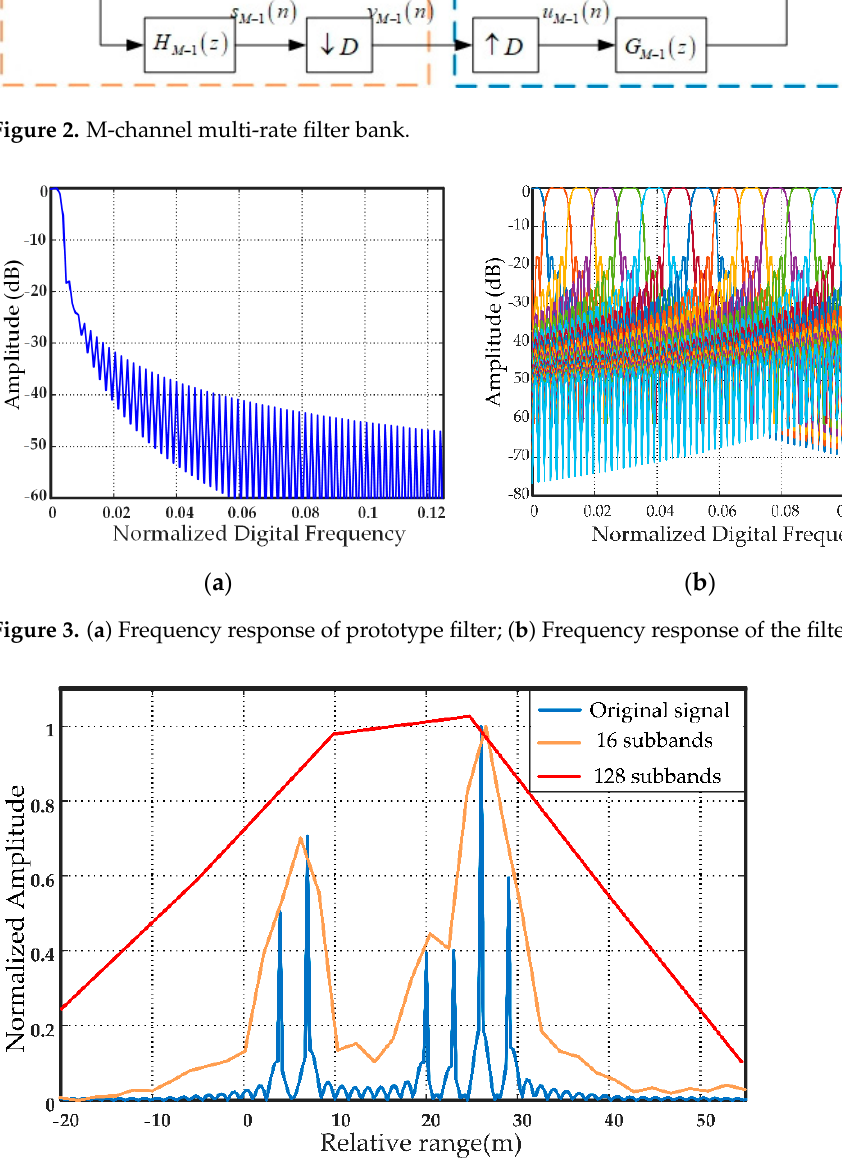
Figure 4. Comparison of signals after different scale transformations.